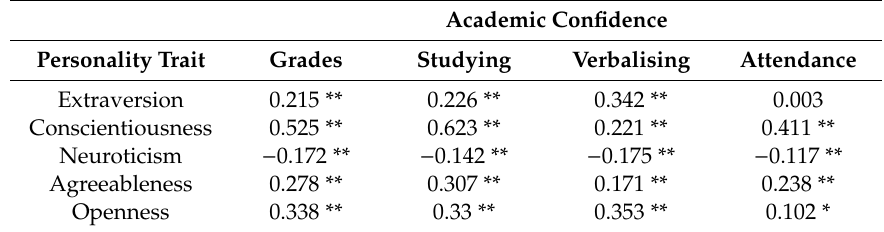
Table 6. Correlation coe ffi cients for the personality factors and the academic confidence